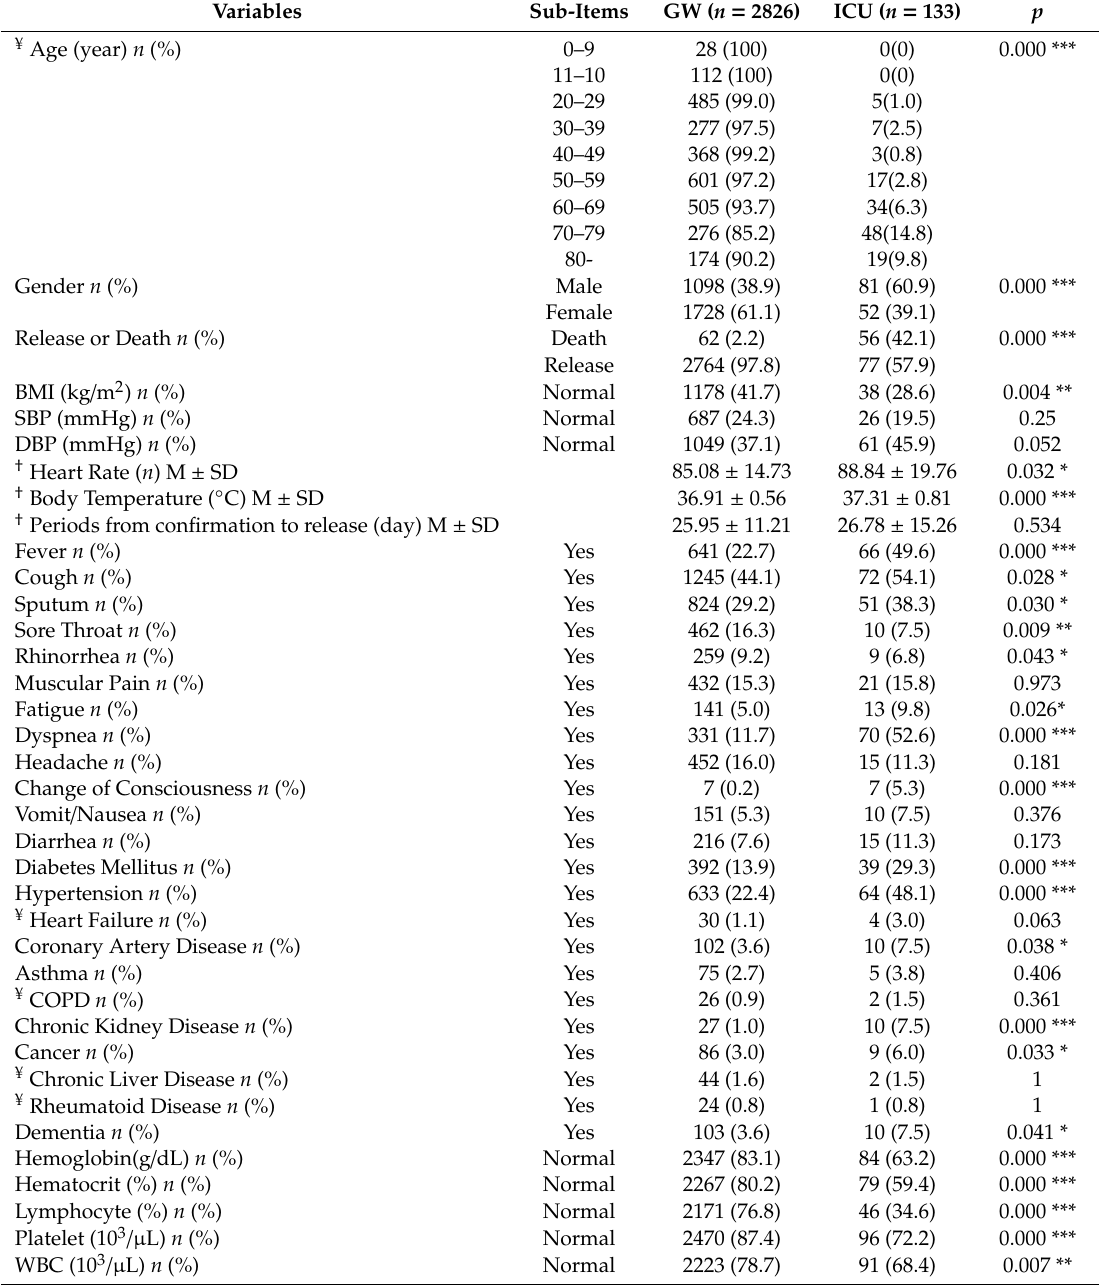
Table 1. Epidemiological and Clinical Variables by hospital